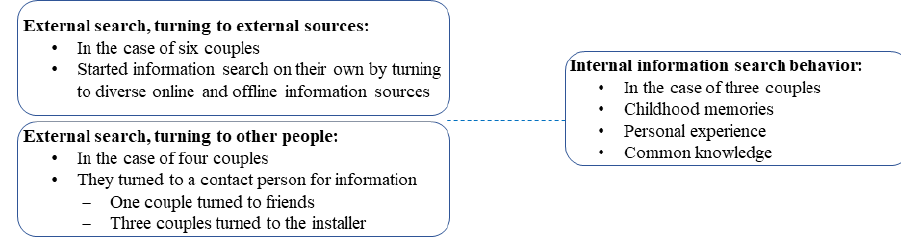
Figure 2. Information search behavior.